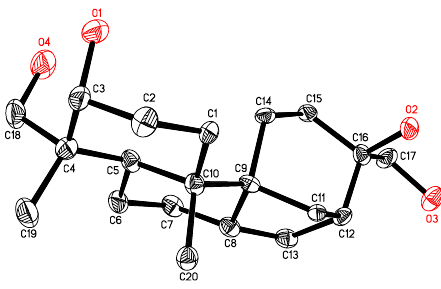
Figure 3. Thermal ellipsoid representation of 4 . Table 1. NMR Data for 1 in Acetone- d 6.